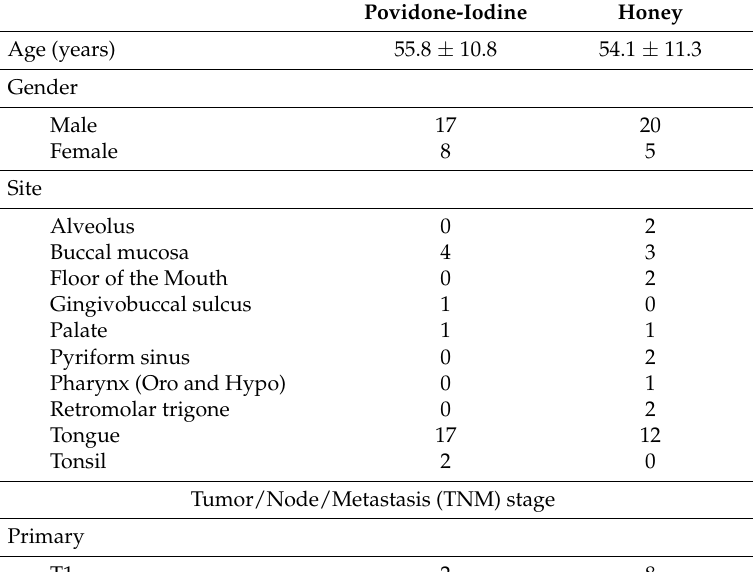
Table 1. Patient details and tumor characteristics.